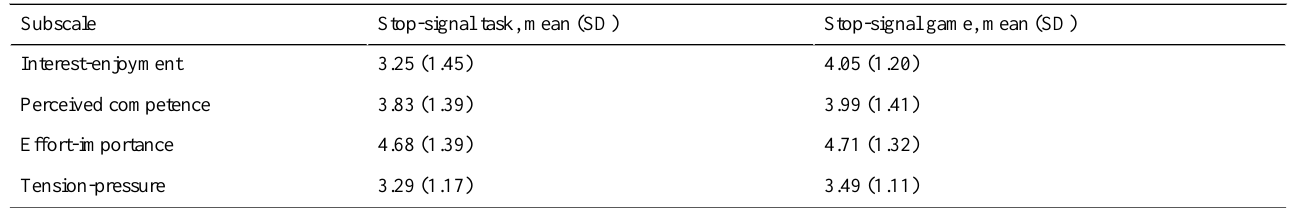
Table 3. Mean scale values for each Intrinsic Motivation Inventory subscale depending on task variant and the study (study 1).